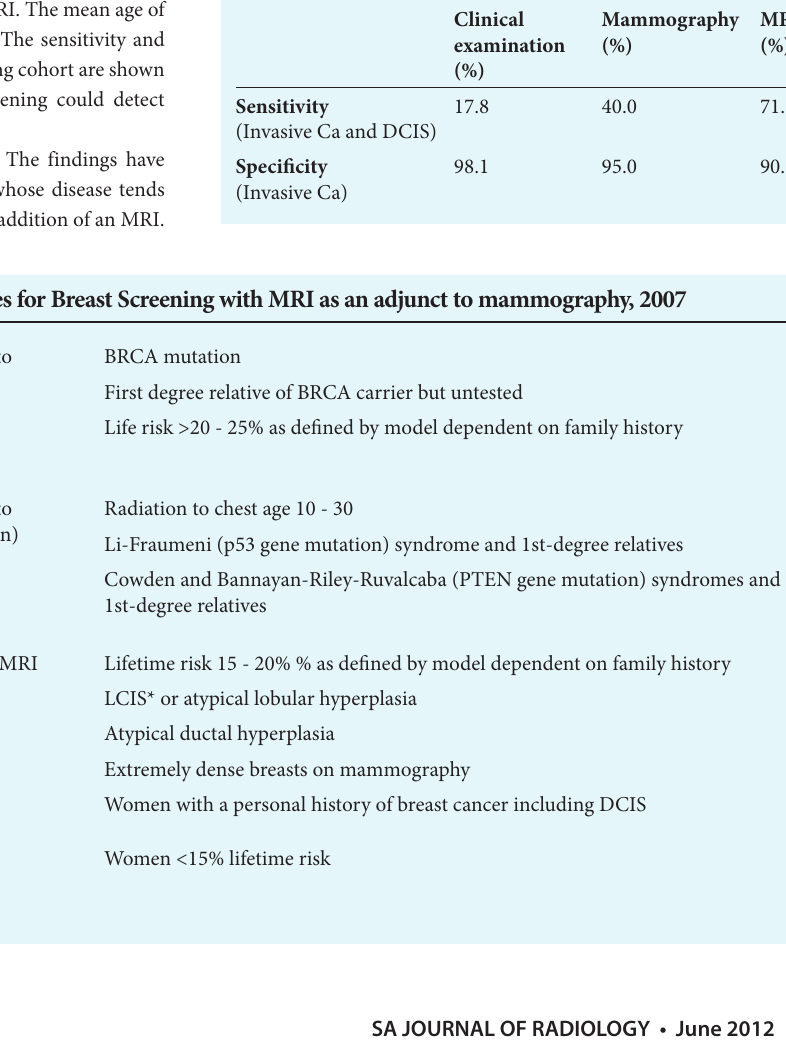
Table 1. Adapted from data in the NEJM 1